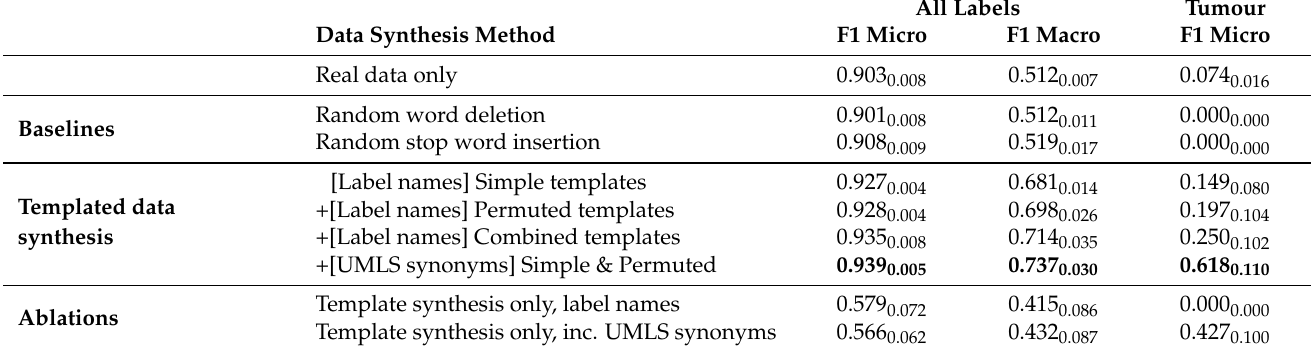
Table 7. Micro- and macro-averaged F1 results on our independent test set as mean standard deviation of 10 runs with different random seeds. Bold indicates the best model for each